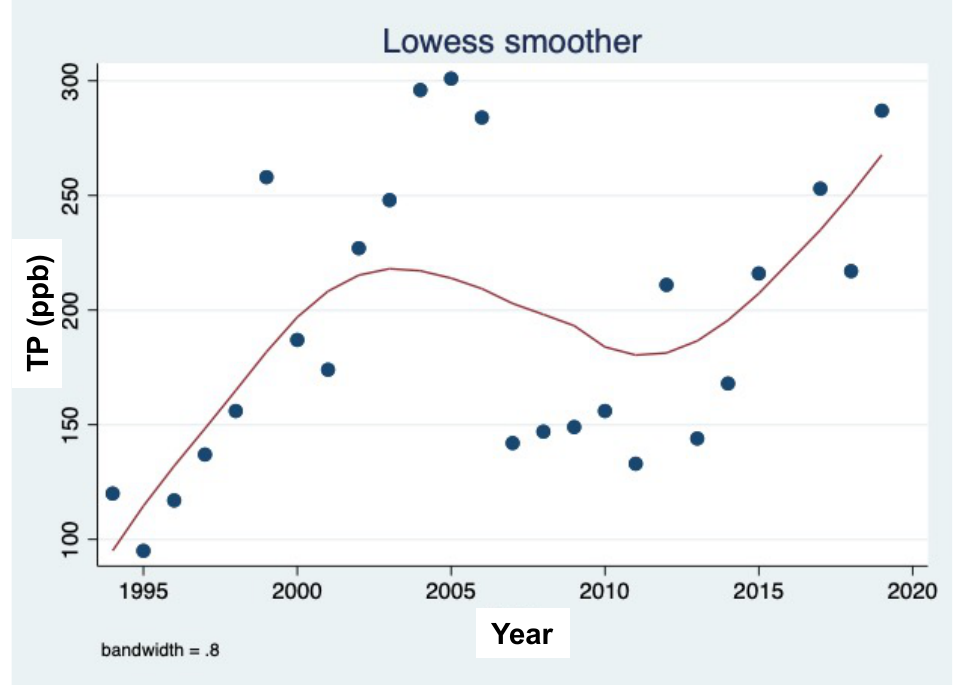
Figure 13. Temporal changes in total phosphorus (TP) concentrations (ppb) in Lake Agmon-Hula. Annual averages vs. years (1994–2020). LOWESS Smoother (bandwidth